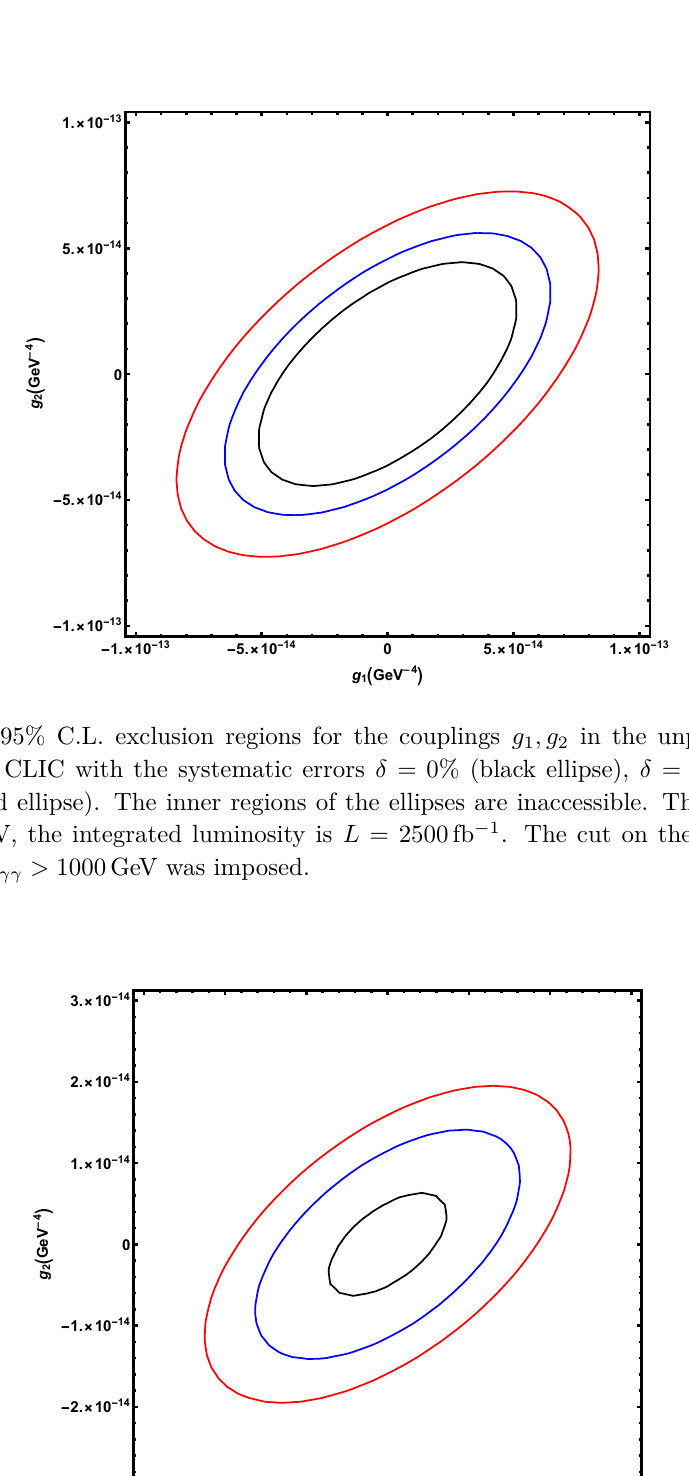
Figure 7 . The same as in figure 6, but for